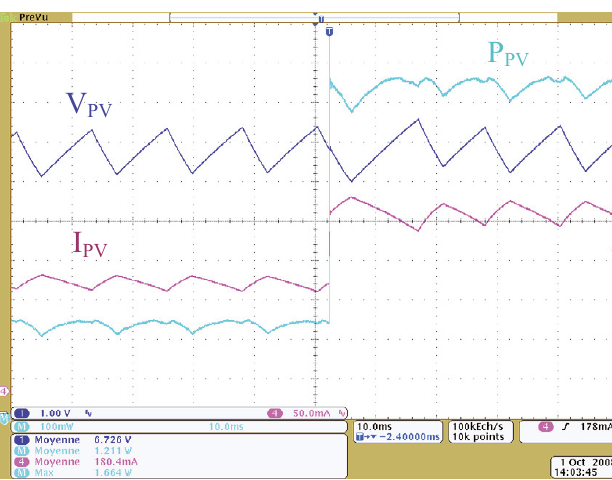
Fig. 6. Response of Boost converter with MPPT to a pertur- bation of